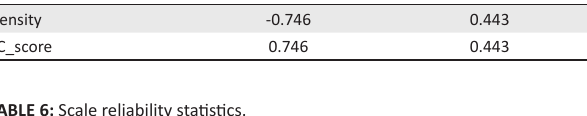
Level of financial